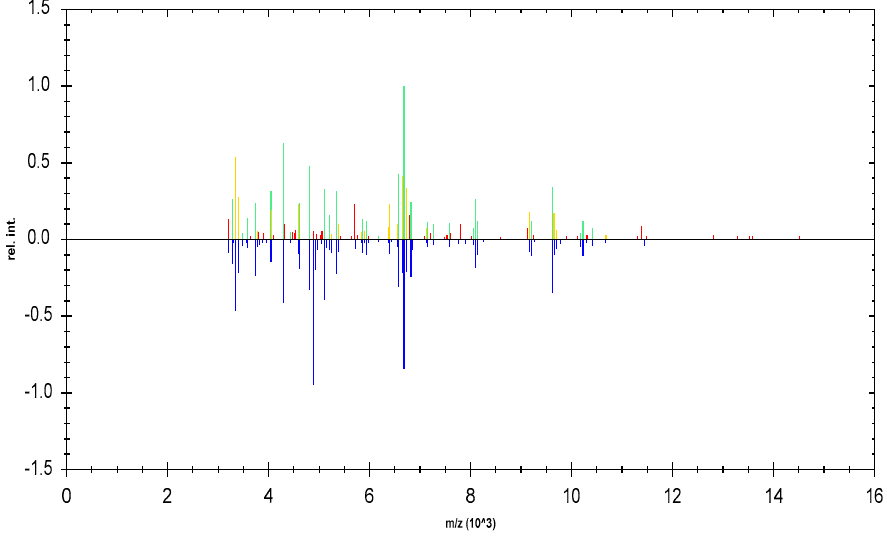
Figure 4. Graphic representation of identification of S. epidermidis (clinical strain) as S. epidermidis biofilm producer. In the upper half of the graph, the normalized peak list spectrum of the unknown sample is shown ( S. epidermidis SE05). In the lower half of the graph, the peak list spectrum of the MSP S. epidermidis 35,984 selected by MALDI Biotyper 3.0 is shown.